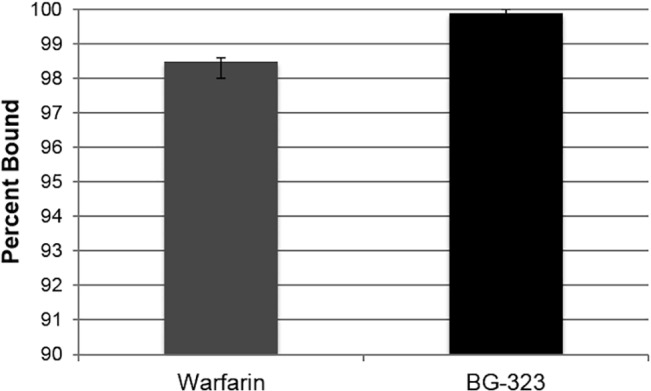
Binding of BG-323 to human plasma proteins.In order to determine the extent to which BG-323 binding human plasma proteins, BG-323 was diluted in plasma and allowed to equilibrate for four hours at 37°C in a Rapid Equilibrium Device. LC-MS/MS was used to quantify the concentration of unbound BG-323 after equilibration. Percent of BG-323 and Warfarin control bound to plasma protein was then calculated.